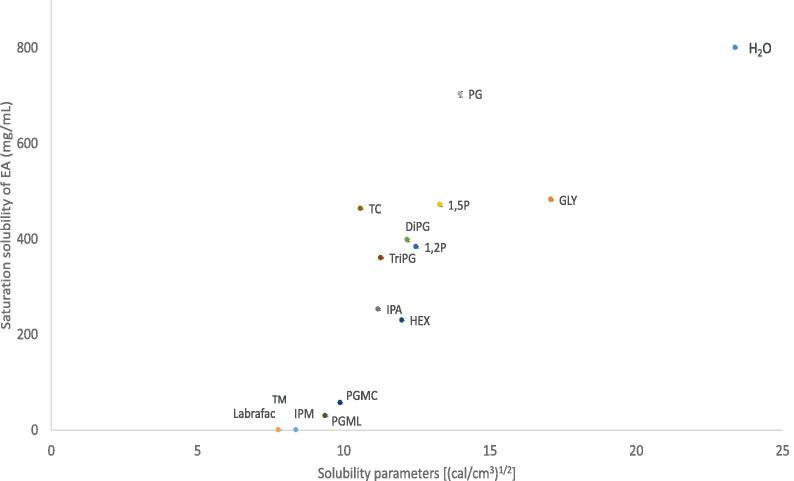
Solubility parameter values of various solvents plotted against saturation solubility of 3-O-ethyl-l-ascorbic acid in vehicles at 32 ± 1 °C, n ≥ 3, mean ± SD.